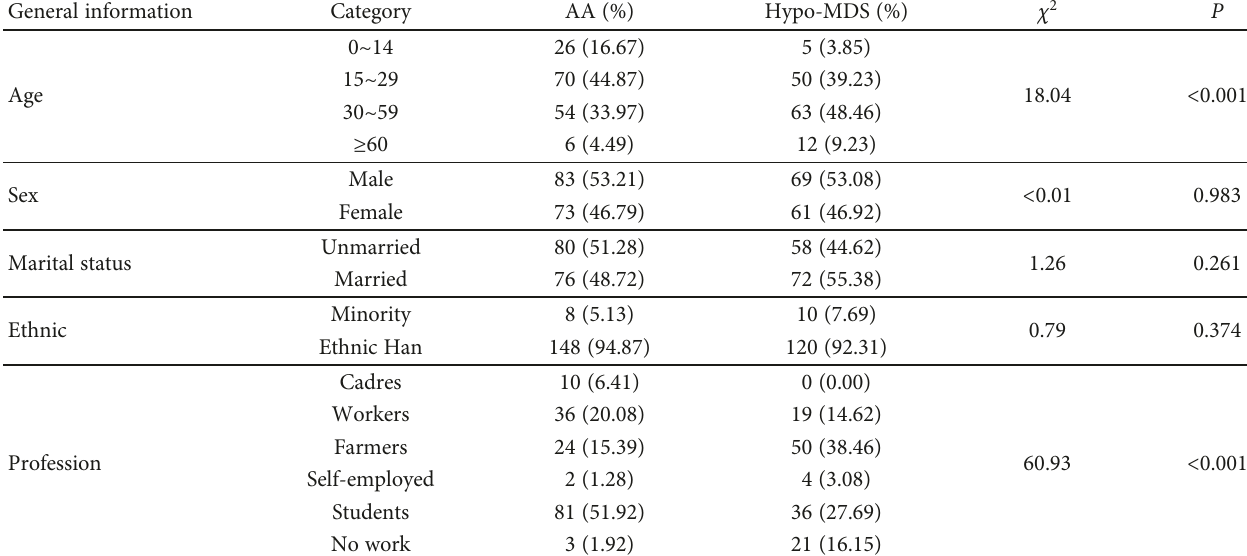
Table 1: The basic characteristics of the patients.